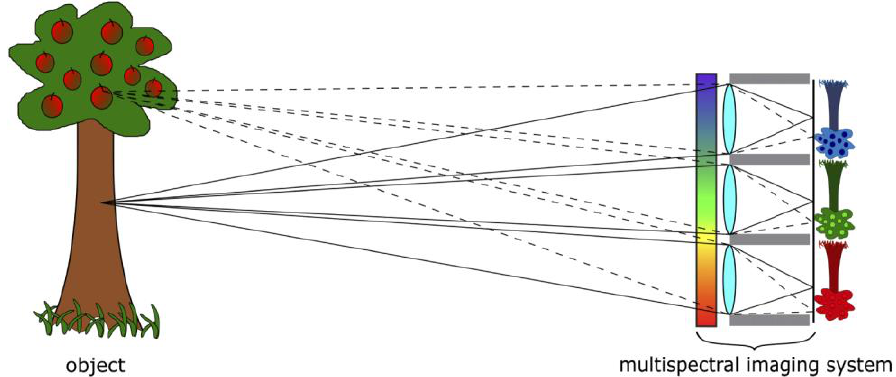
Figure 30. Working principle of the proposed MSI system capturing an object via remote sensing. Each channel captures only a certain spectral part of the object.